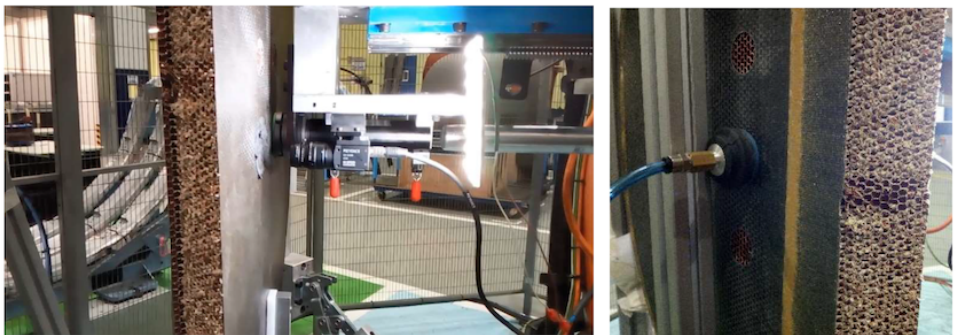
Figure 9. Test of the vacuum-assisted multi cell injection system. Left : The end-effector is located at one side of the panel by the robot arm. The optical camera and light-panel help the operation. Right : A vacuum nozzle is located at the opposite side of the panel to assist the resin